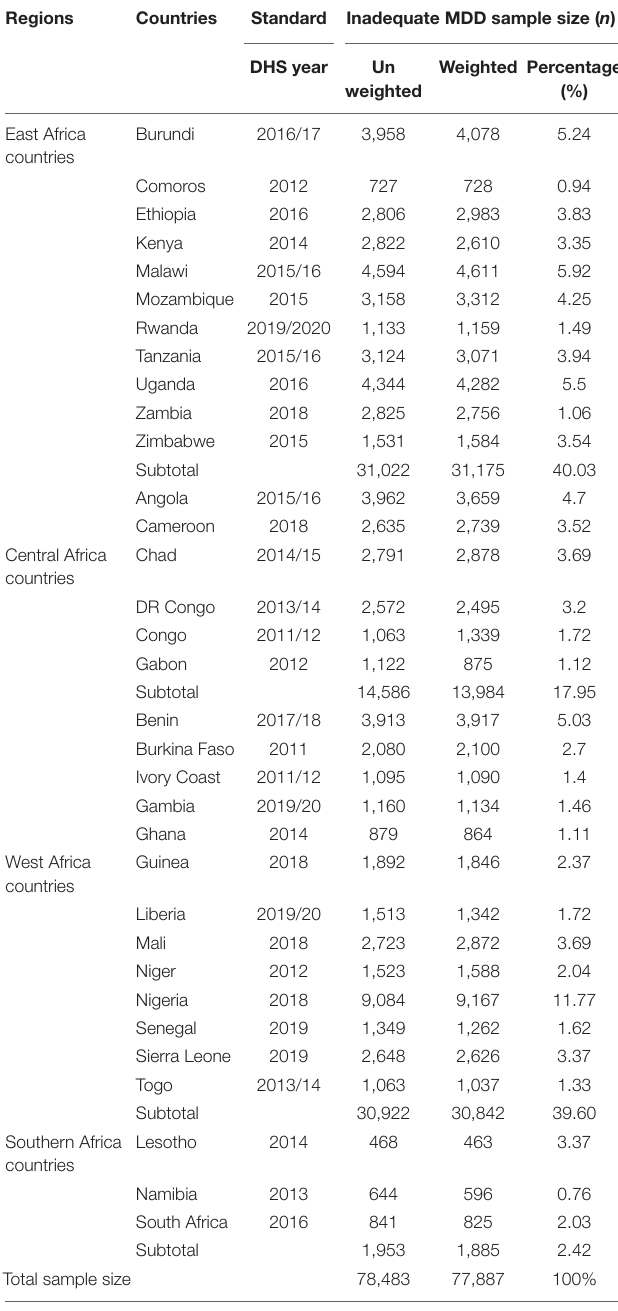
TABLE 1 | Sample size determination of inadequate minimum dietary diversity intake and factors associated with it among children aged 6–23 months in each sub-Saharan Africa country: based on 2010–2020 DHS. Sub-Saharan Africa Countries with Recent DHS report from 2010/11 to 2019/20